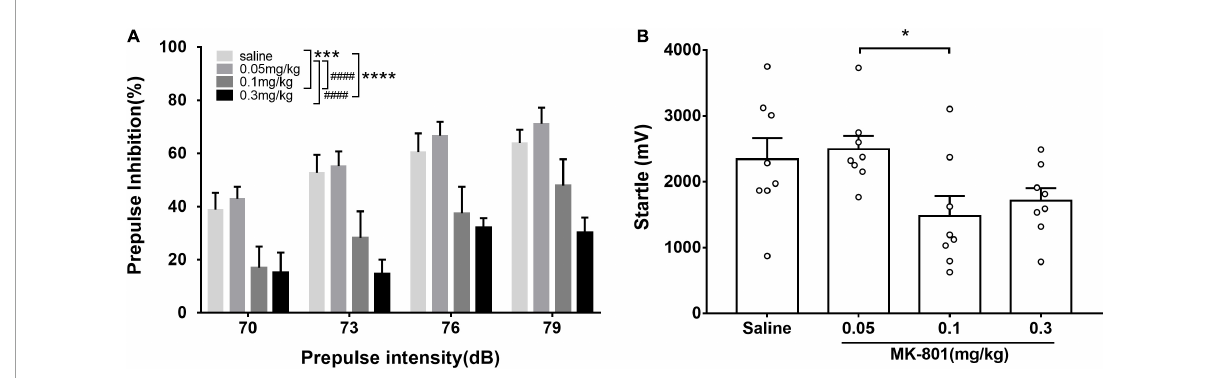
FIGURE1 Acute MK-801 administration disrupted the prepulse inhibition of mice. PPI testing started after 30 min. drug injection. The prepulse inhibition (A) and amplitude of 120 dB responses (B) were analyzed. All values were expressed as mean ± SEM ( n = 8 mice per group). * p < 0 . 05, *** p < 0 . 001, **** p < 0 . 0001 compared with the saline group and #### p < 0 . 0001 compared with the 0.3 mg/kg group as revealed by Tukey’s multiple comparisons